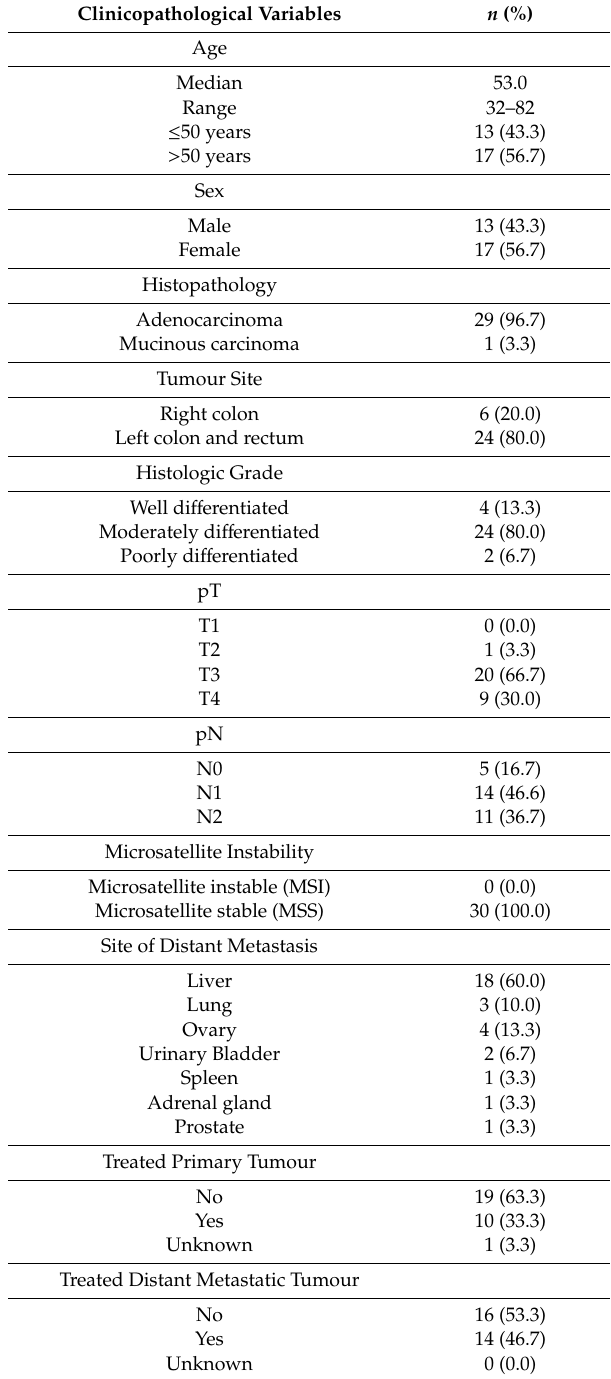
Table 1. Clinicopathological variables for the metastatic colorectal cancer cohort ( n =